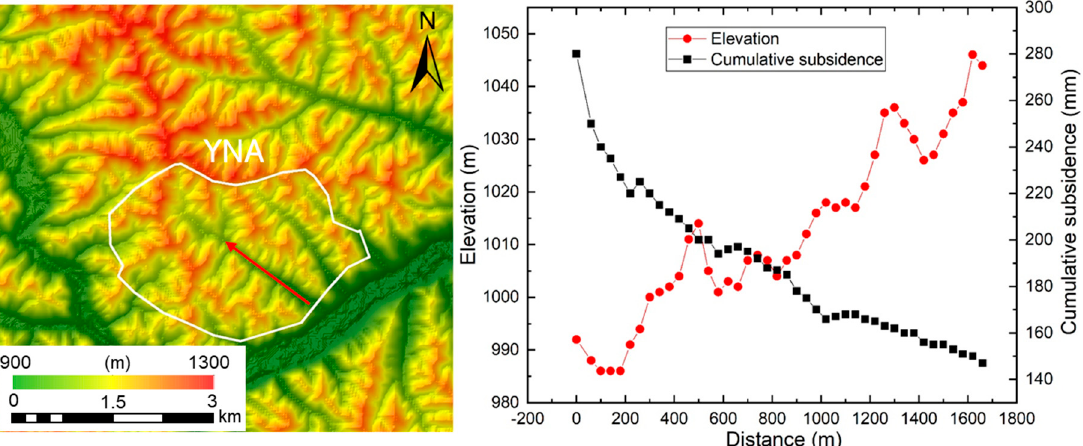
Figure 6. The correlation between elevation variation along the filling region and cumulative subsidence. The elevation is obtained along the red line in the left figure at the direction of southeast towards northwest with an interval of 40 m. The cumulative subsidence is calculated within the region by average. The x -axis of right figure represents the collection interval of the elevation.